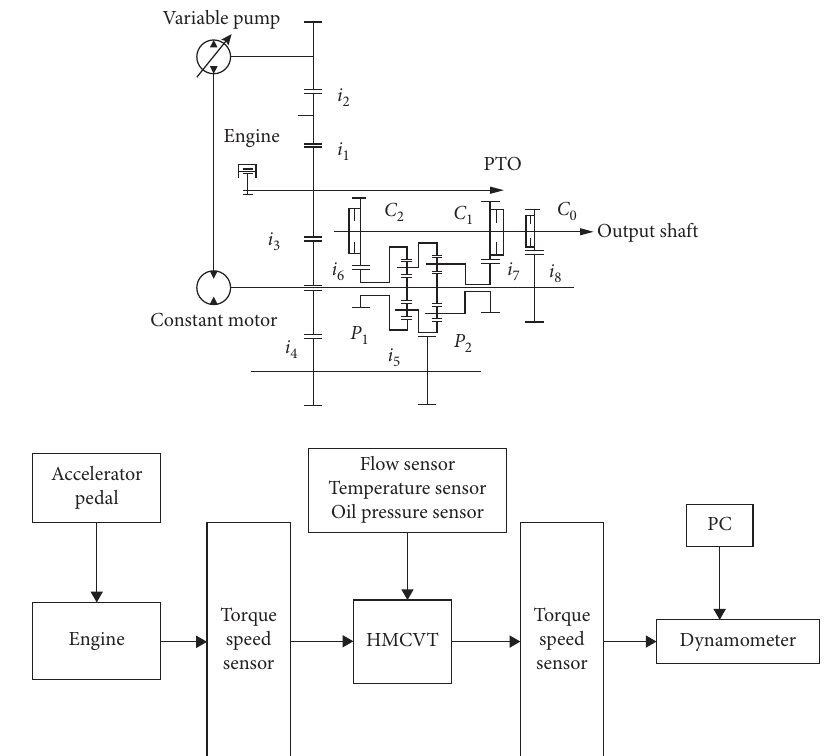
Figure 2: Schematic diagram of HMCVT.